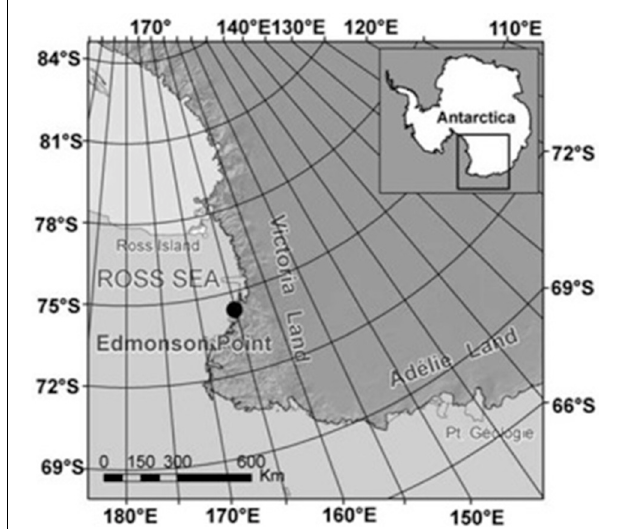
FIGURE 1 | The Adélie penguin colony of Edmonson Point is located on an ice-free area at 74 ◦ 20 S, 165 ◦ 08 E, along the Victoria Land coast, Ross Sea,